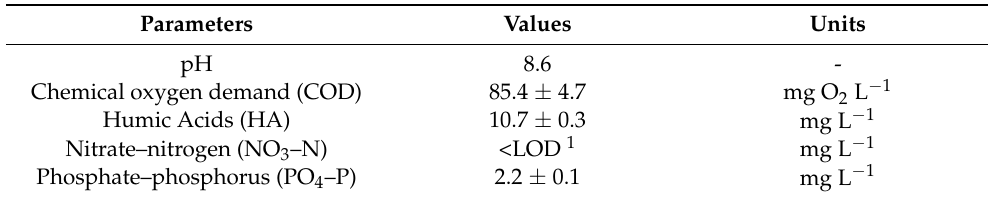
Table 1. Physicochemical characterization of the urban effluent collected after the secondary clarifier and used in this study.